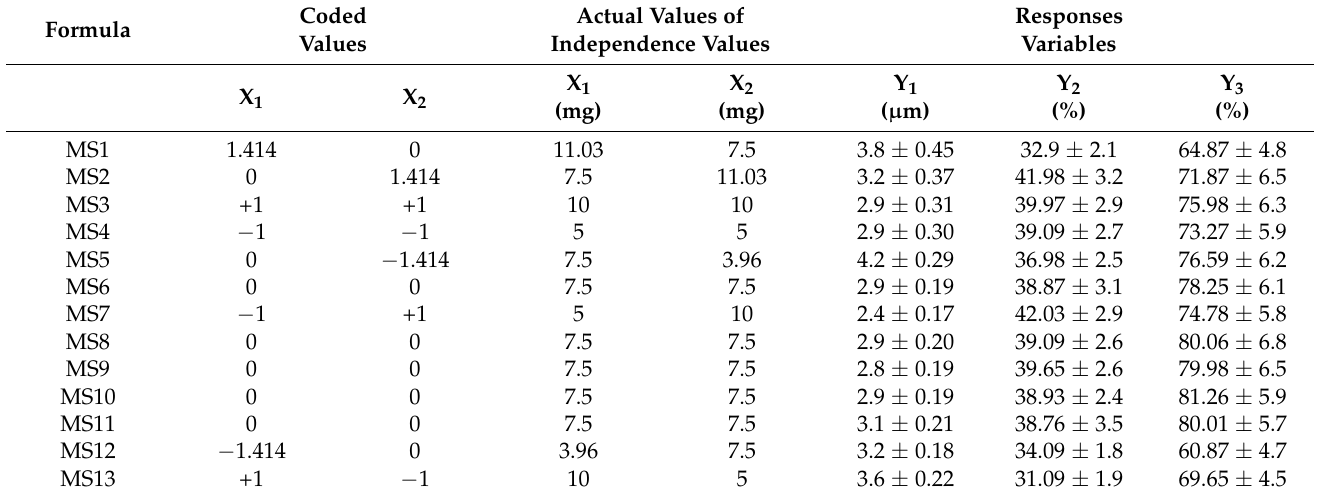
Table 1. Experimental design matrix of the central composite design with experimental results.